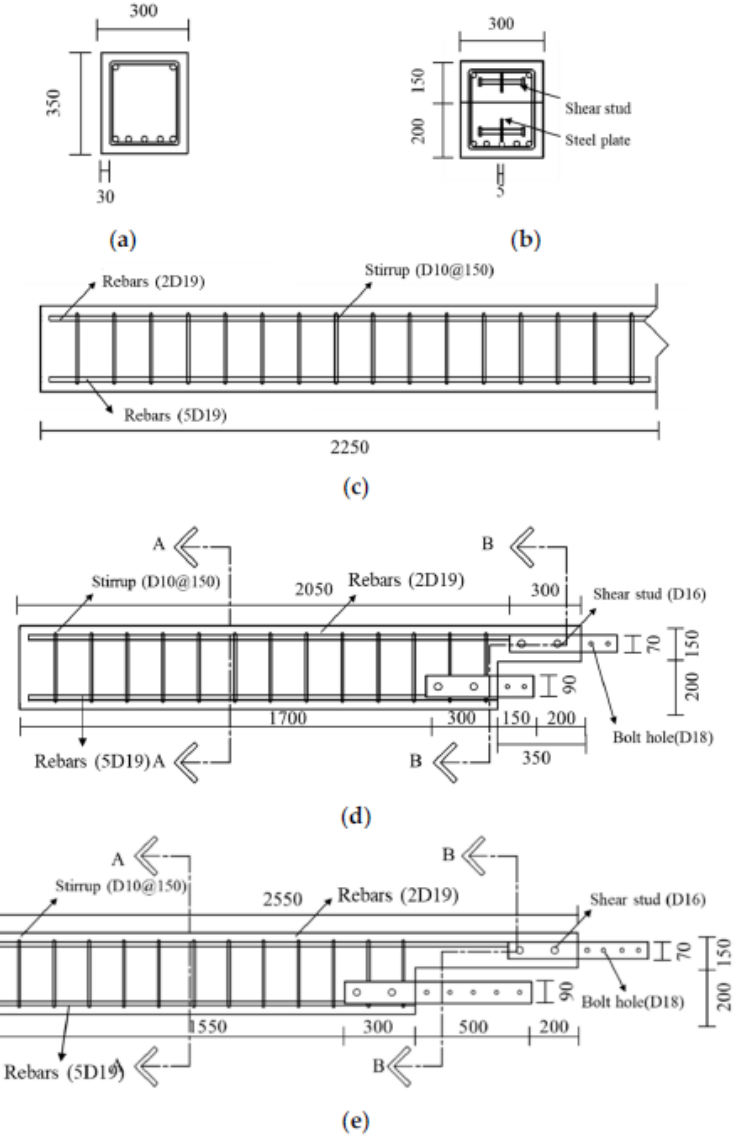
Figure 7. Details of specimens (mm): ( a ) A-A section; ( b ) B-B section; ( c ) side view of CRC; ( d ) side view of PCM-A; ( e ) side view of